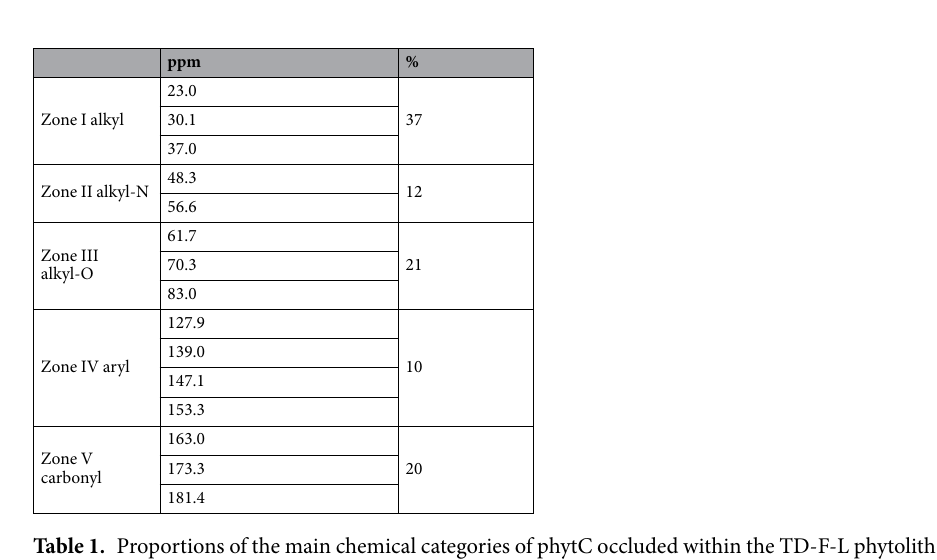
Figure 2. DNP 1 H- 13 C CP-MAS spectrum of the TD-F-L phytolith sample (black) and its line fitting (red) with Gaussian peaks (blue), Roman numerals refer to the main chemical categories of Table 1.